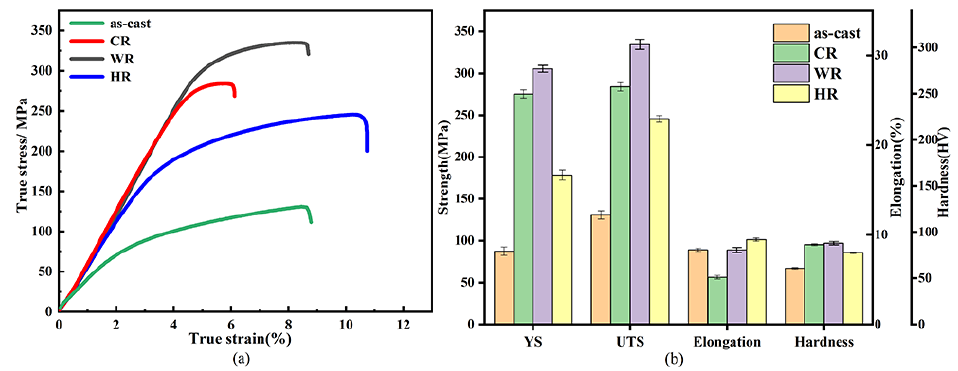
Figure 5. Mechanical properties of as-cast, CR, WR, and HR samples of WE43 alloy: ( a ) tensile stress–strain curves ( b ) yield strength, ultimate tensile strength, elongation, and hardness. Table 2. Mechanical properties and hardness of WE43 alloy as-cast, CR, WR, and HR samples.